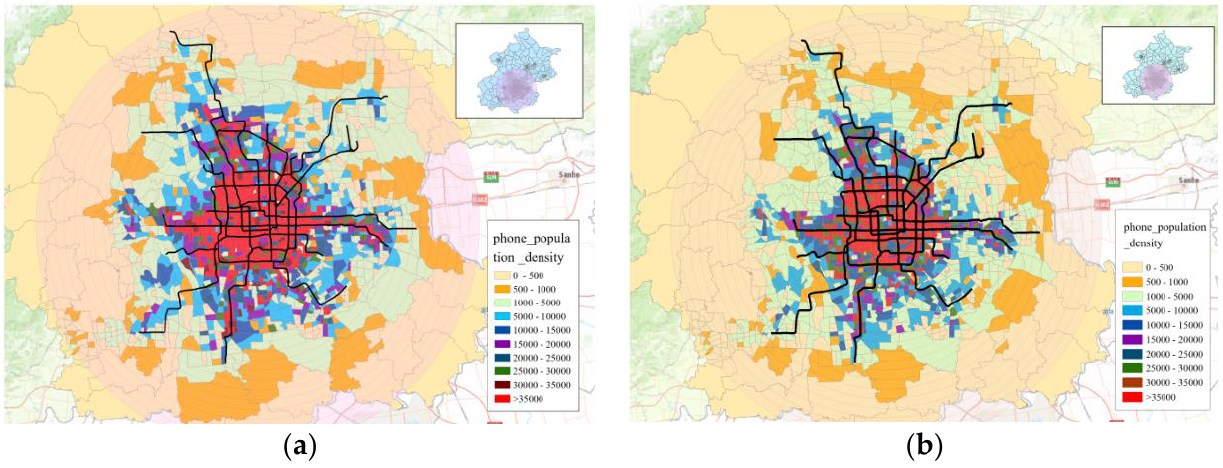
Figure 11. Population distribution ( a ) from 7 a.m. to 8 a.m. and ( b ) from 5 p.m. to 6 p.m.